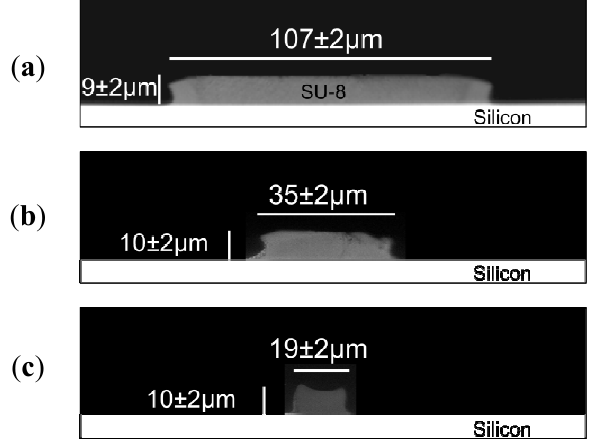
Figure 6. Microscope images of microchannel cross sections with three different widths,